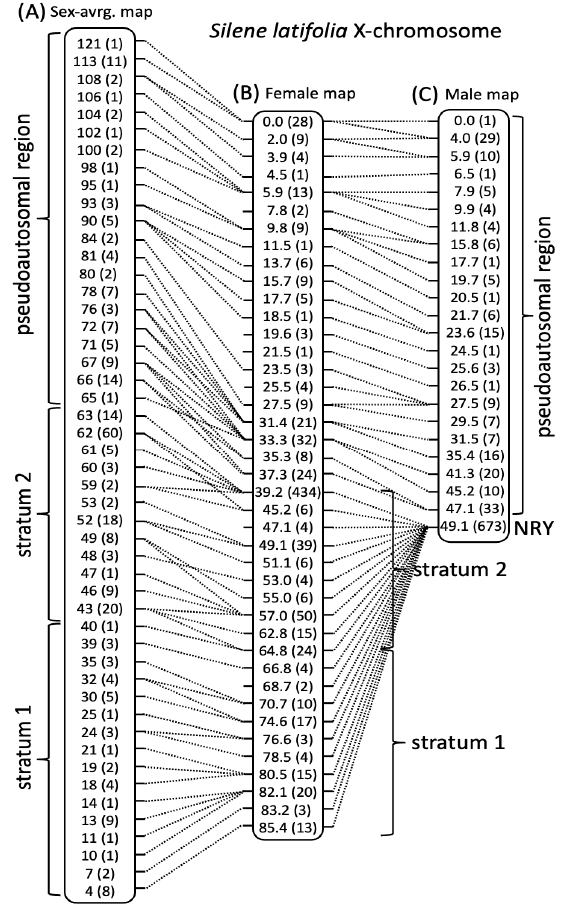
Figure 1. Comparison of genetic maps for the X-chromosome of S. latifolia . ( A ) Sex-average map showing only the markers shared with the female map constructed in this study ( B ). ( C ) Male genetic map. The genetic distances are shown for each position (in cM), rounded to integer values in ( A ). The numbers of genes sharing the same or very similar position are shown in brackets. The genetic positions sharing genic markers in different maps are connected by dotted lines. The locations of the pseudoautosomal region (PAR), the non-recombining Y-linked region (NRY) and two evolutionary strata are shown. Table 1. The comparison of female, male and sex-average S. latifolia genetic maps.